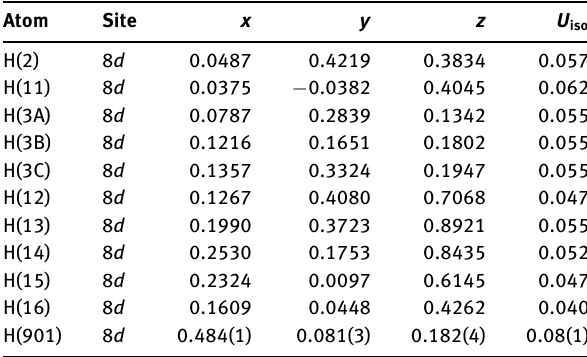
Table 2: Atomic coordinates and displacement parameters (in Å 2